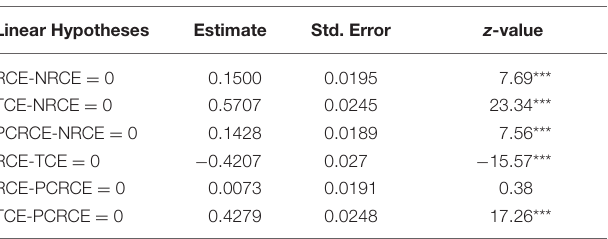
TABLE 2 | Experiment 1 linear mixed models analysis of z-score transformed sentence